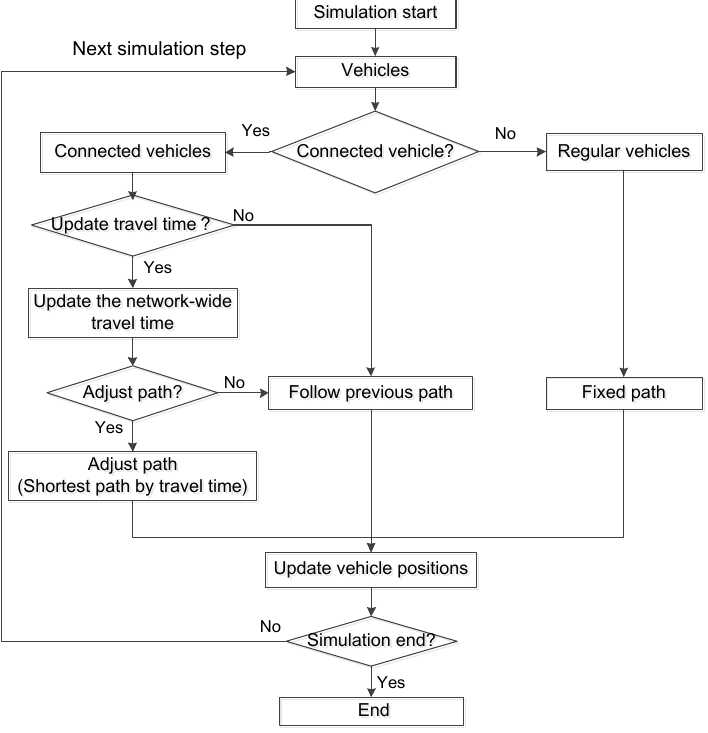
Figure 1. Framework of a connected vehicle in the